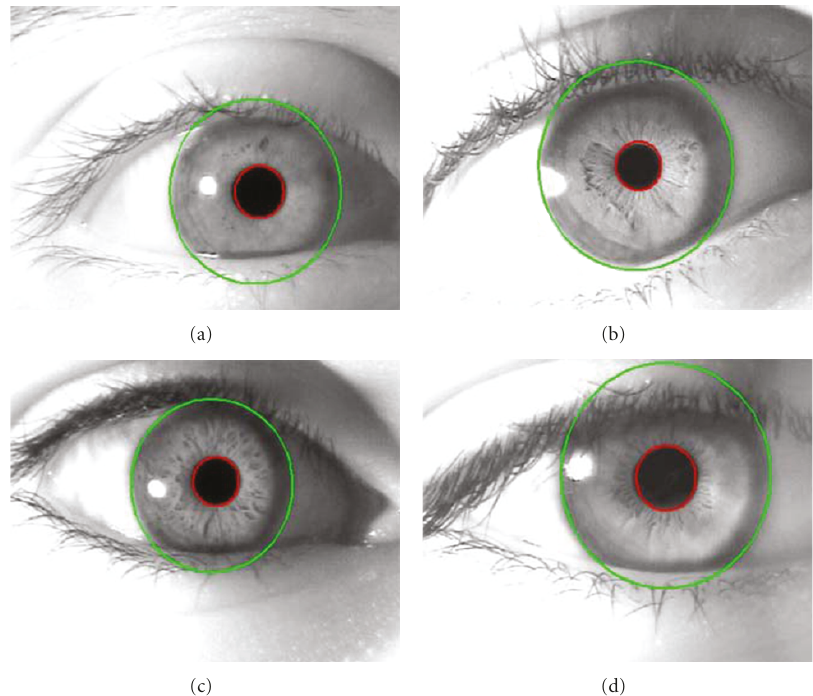
Figure 16: Results of applying the segmentation described in Section 3.3.1 on eye images acquired using our setup. The pupillary boundary is depicted by the red circle while the limbic boundary is depicted by the green circle. The iris pattern is isolated by simply cropping out the region between these two